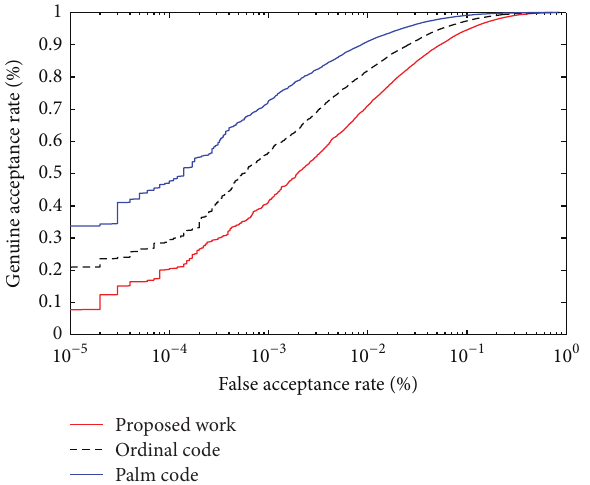
Figure 17: ROC curve using both local and global features of proposed DOST for PolyU palmprint database.